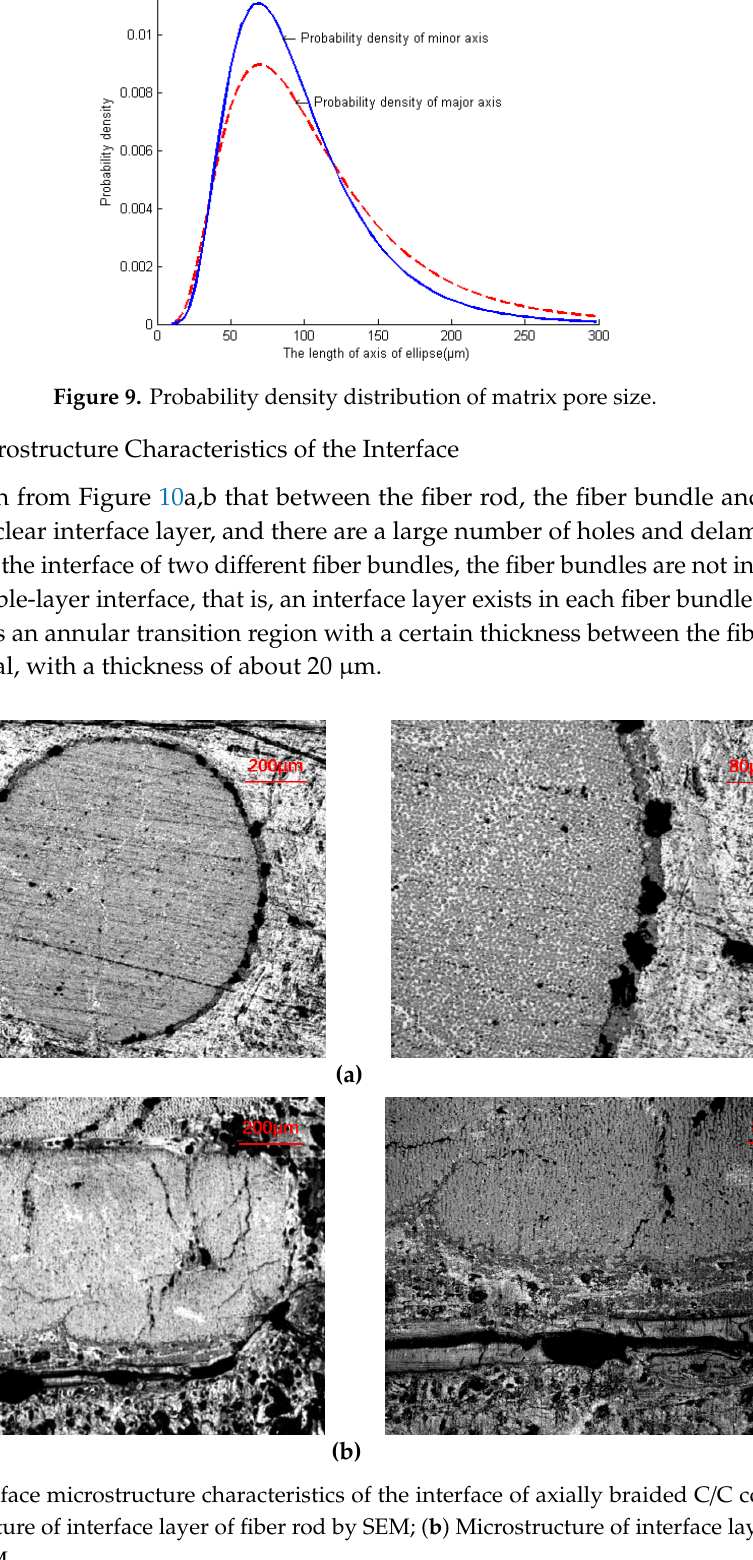
Figure 8. Equivalent test method for pores.